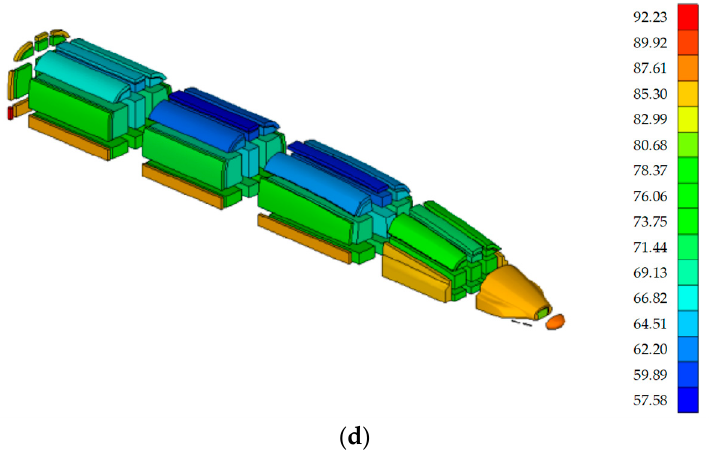
Figure 9. Interior aerodynamic noise of tail car: ( a ) 100 Hz, ( b ) 500 Hz, ( c ) 1000 Hz, ( d ) 2000 Hz.